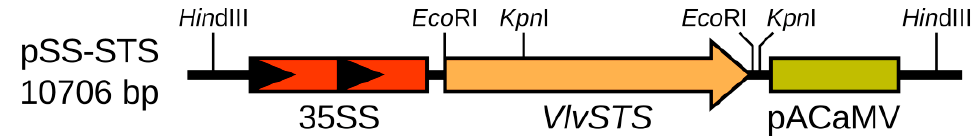
Figure 1. Schematic diagram of pSS-STS plasmid. CaMV35SS and pACaMV—promoter with two enhancer domains and polyadenylation signal of cauliflower mosaic virus 35S RNA; VlvSTS— stilbene synthase gene of hybrid grape V. labrusca x V. vinifera L.; npt II — gene of neomycin phos- photransferase II.